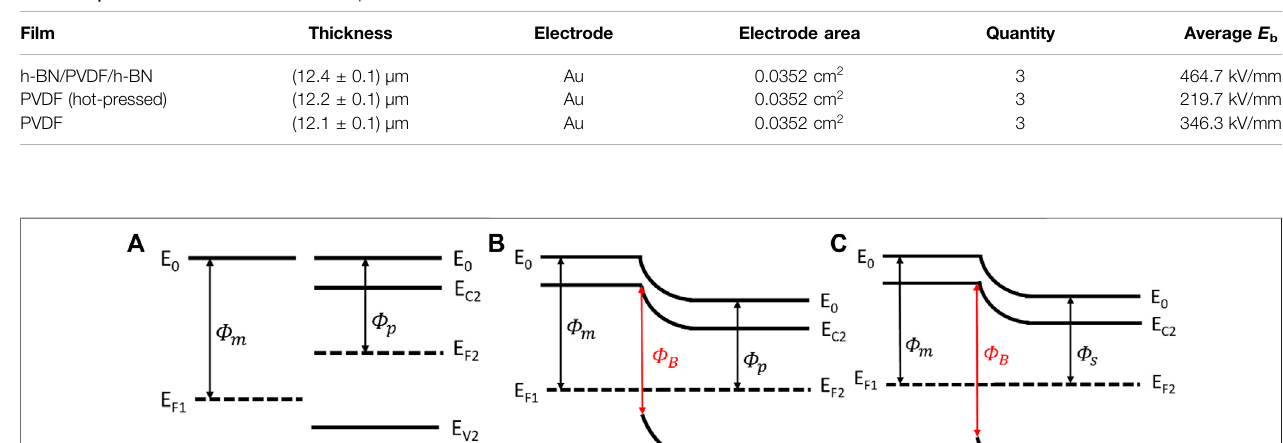
TABLE 1 | Parameters of three kinds of samples.